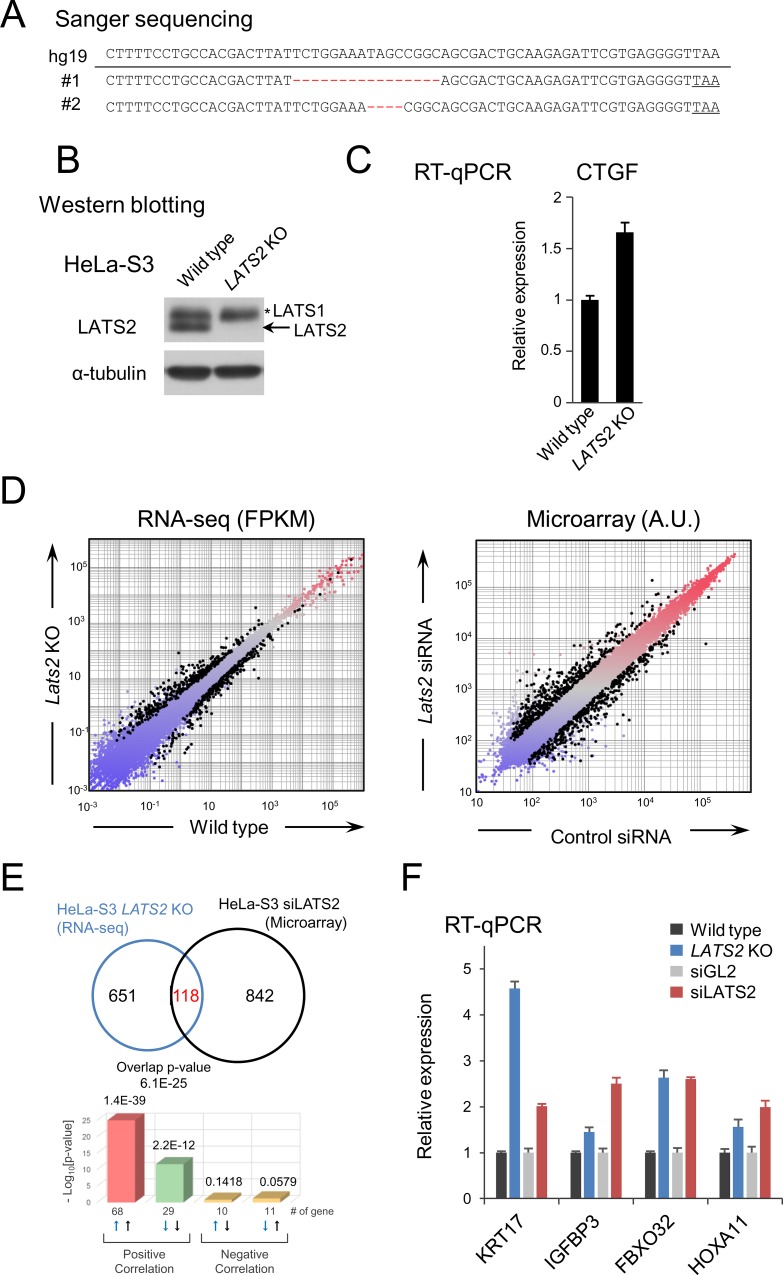
Construction of LATS2 KO HeLa-S3 cells.(A) Genomic sequences of the wild type LATS2 locus (hg19) and the LATS2 KO mutations generated in HeLa-S3 cells. The TALEN-targeted regions of the genome were amplified by genomic PCR, the PCR products were sub-cloned, and each clone was subjected to Sanger sequencing. (B) Confirmation of LATS2 KO by western blotting. The anti-LATS2 polyclonal antibody used recognizes the N-termini of both LATS2 and LATS1. Arrow represents LATS2 signals. ‘*LATS1’ indicates LATS1 signals. (C) Gene expression analysis of CTGF, which is under the control of YAP/TAZ, showing perturbation of the intrinsic Hippo signal. RT-qPCR was performed in two independent experiments, and mRNA levels were normalized to ACTB; Error bars show standard deviation (SD). (D) Left: Scatter plot of RNA-seq data comparing LATS2 KO and wild type HeLa-S3 cells. DEGs (≥2-fold, p-value <0.05) are highlighted in black dots. Right: Scatter plot of microarray data comparing LATS2 knockdown and control siRNA HeLa-S3 cells. DEGs (≥1.4-fold, probes expressing in both samples [i.e., ‘wellAboveBG-FLAG’ is TRUE] are highlighted in black dots. (E) Significant overlap of DEGs in LATS2 KO HeLa-S3 cells and HeLa-S3 cells treated with siRNA targeting LATS2. DEGs in LATS2 KO and siLATS2 HeLa-S3 cells were subjected to NextBio analysis. Venn diagrams show the number of common and unique genes in both sets. Bar plots show the significance of overlap in each direction. (F) Gene expression analysis for a series of DEGs in LATS2 KO HeLa-S3 cells and LATS2 knockdown HeLa-S3 cells. RT-qPCR was performed in two independent experiments, and the levels of each transcript were normalized to ACTB; Error bars show SD.